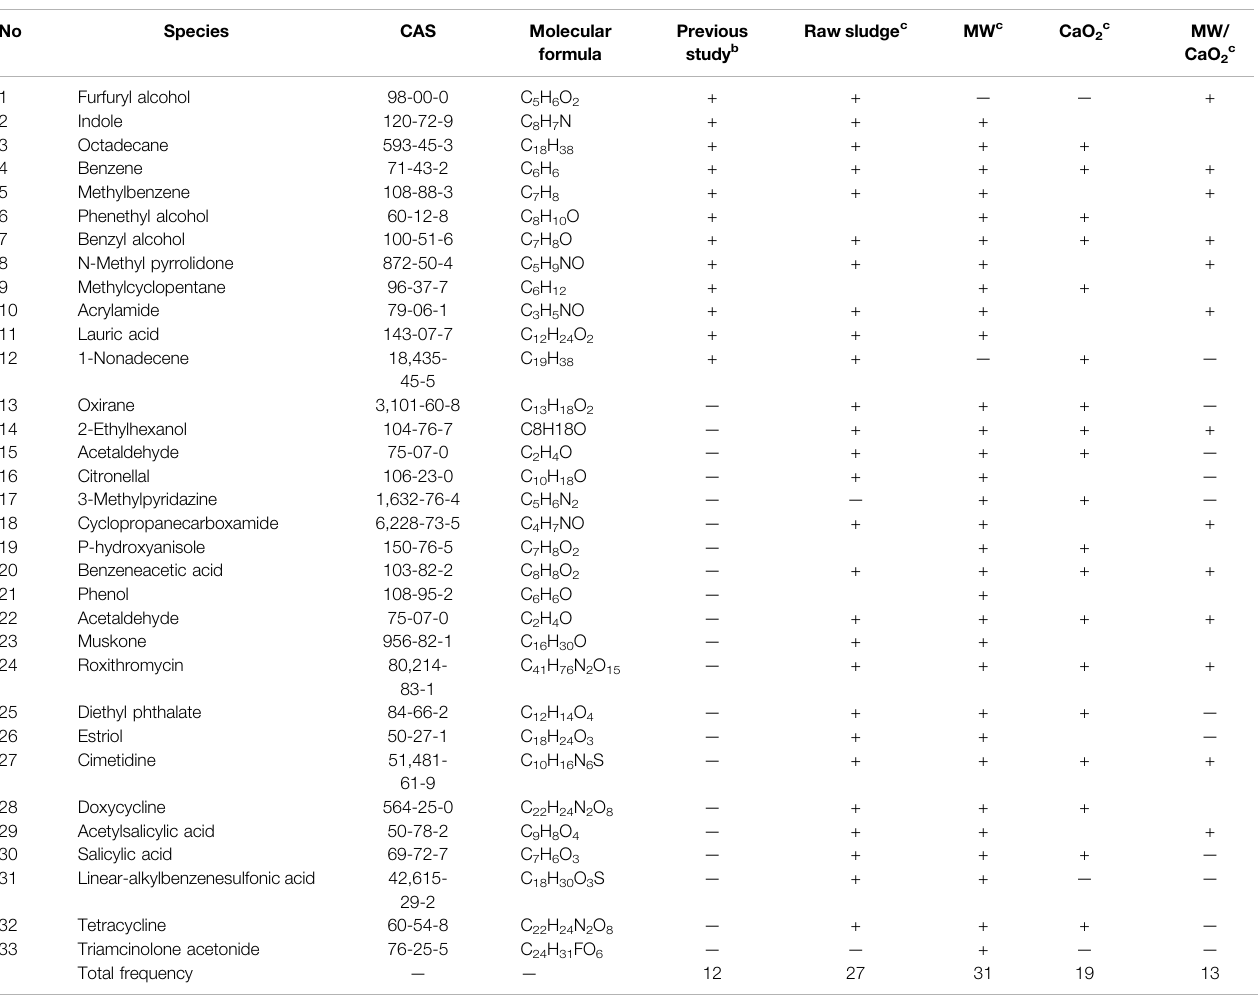
TABLE 5 | Organic pollutants detected in different sludge samples.